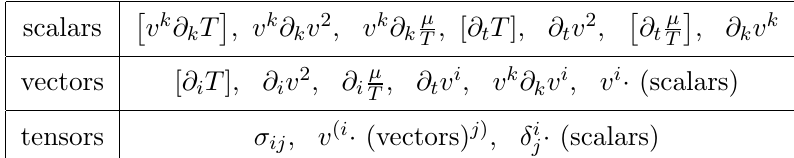
(cid:14) i j 2 @ k v k is the d (cid:0)